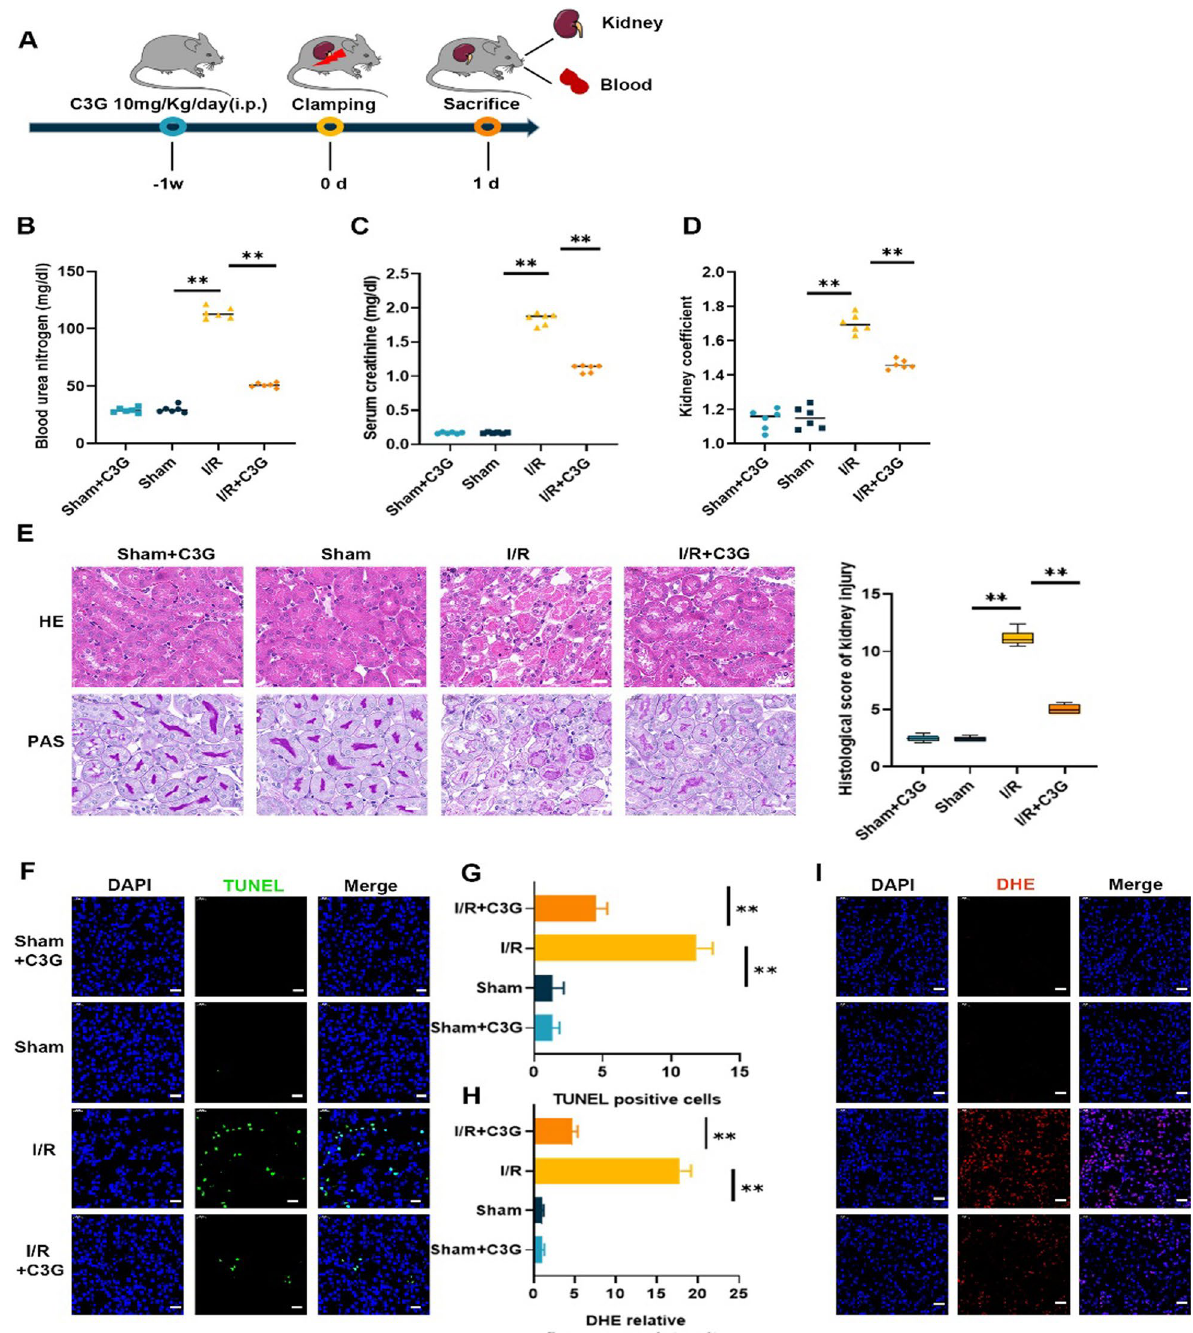
Fig. 3 Treatment of C3G attenuated I/R‑AKI in vivo. A Schematic of renal I/R generation and treatment of C3G for one week in advanced; B – D BUN, Scr levels and kidney coefficient. Kidney coefficient Kidney weight/body weight 100. (n 6); E Representative micrographs of HE and = × = PAS staining of kidney from sham C3G, sham, I/R and I/R C3G group. The pathological scores of kidney injury were graded. Scale bars + + (n 6); F , G Representative terminal deoxynucleotidyl transferase dUTP nick‑end label‑ (TUNEL‑) stained sections of different groups in kidney. Scale = bars 20 μm. (n 6); H , I Representative immunofluorescence images of ROS were captured and analyzed by the ratio of ROS positive cells/total = = cells. Scale bars 20 μm. (n 6). *p < 0.05, **p < 0.001. C3G cyanidin‑3‑glucoside, I/R-AKI ischemia/reperfusion‑induced acute kidney injury, BUN = = blood urea nitrogen, Scr serum creatinine, HE hematoxylin and eosin, PAS Periodic acid‑Schiff, ROS reactive oxygen